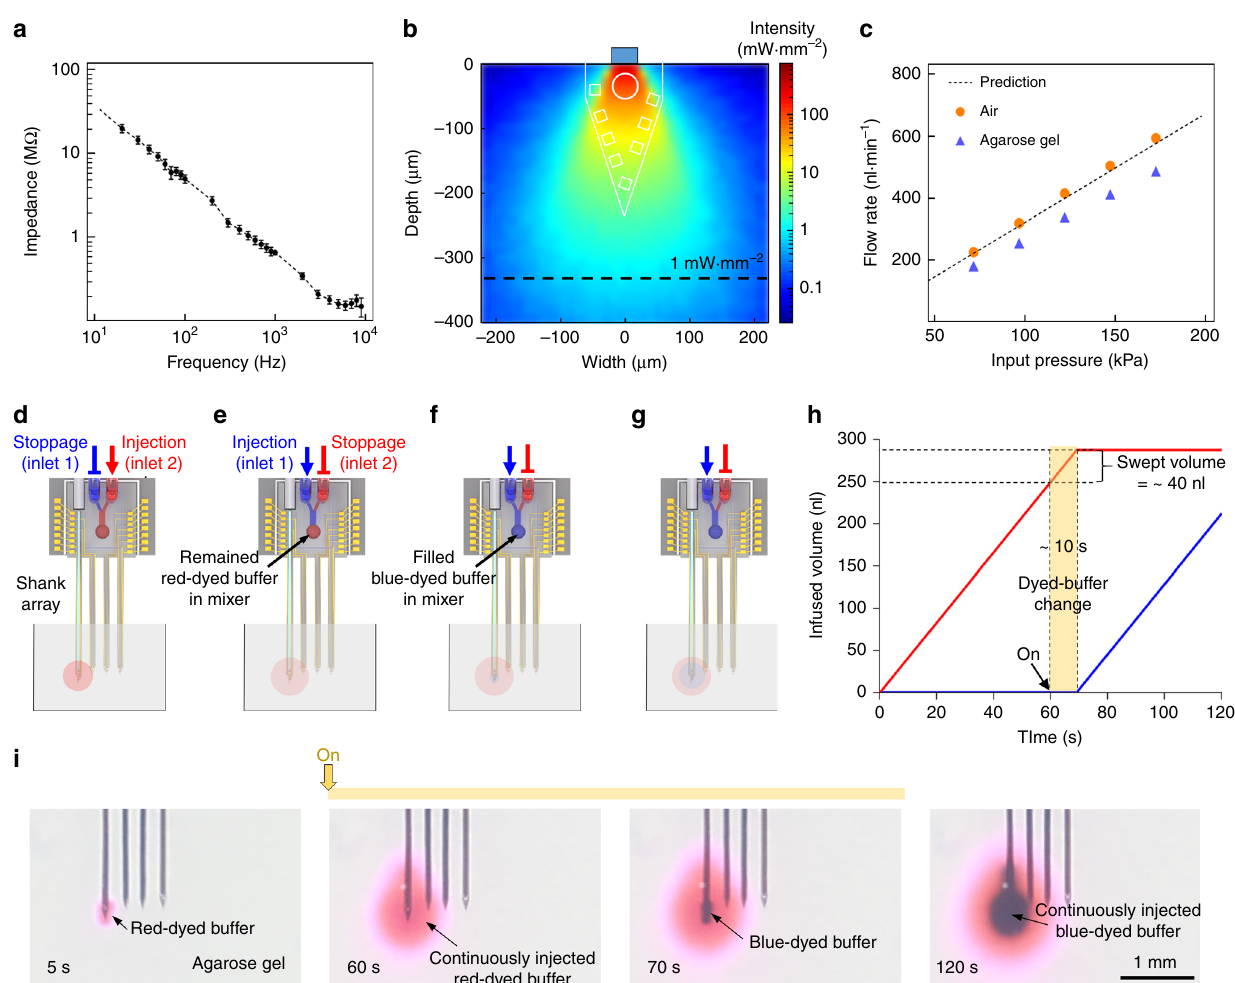
Fig. 2 Characterization of the multifunctional multi-shank MEMS neural probe: a Impedance plot of 32 the Iridium microelectrodes. Error bars indicate s.d.; b Simulated light intensity map in brain tissue using Monte Carlo simulation based on measured output power (blue light, 454 μ W at the end of the SU-8 waveguide); c Plot of fl ow rates with different input pressures; d – g Schematic diagram of multi-dyed buffer injection: d Loaded red-dyed buffer injection in inlet 2; e A stoppage of red-dyed buffer injection to the agarose gel and loaded blue-dyed buffer injection in inlet 1; f Blue-dyed buffer injection into the agarose gel after fl ushing out the fi lled red-dyed buffer dye in the micro fl uidic mixer; g Continuous infusion of the blue-dyed buffer into the agarose gel; h Plot of the infused volume of red- and blue-dyed buffers from the probe to 0.9% agarose gel; i Sequential photographs of multi-dyed buffer injection in 0.9% agarose gel when the fl ow rate was 0.3 μ l ⋅ mim −